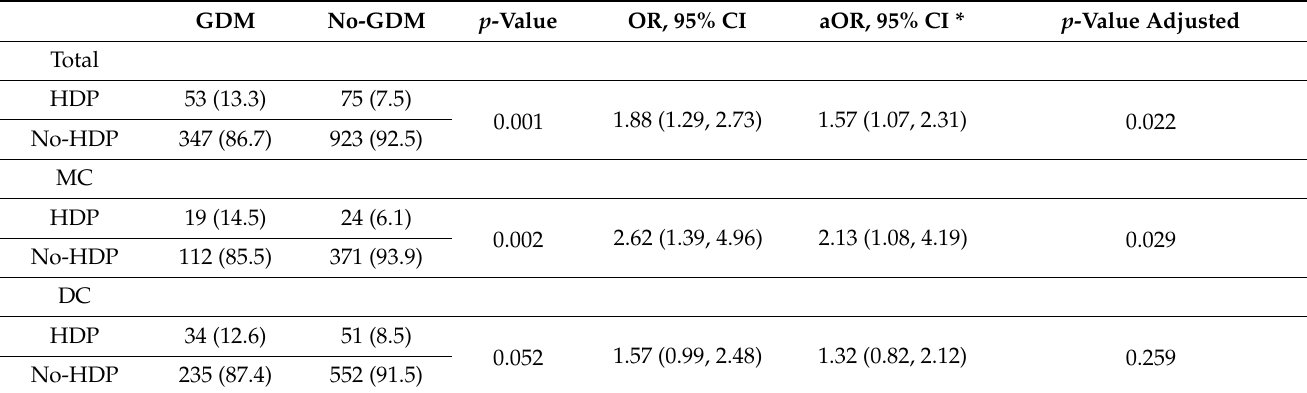
Table 2. HDP incidence among twin pregnancies with GDM, stratified by chorionicity.